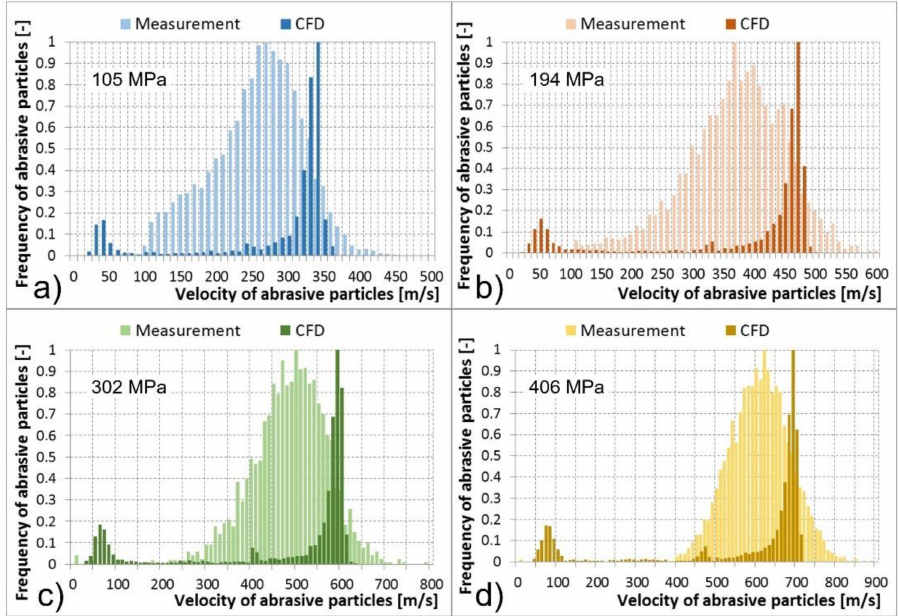
Figure 15. Abrasive particle velocities at the abrasive nozzle outlet, measurement vs. computational models for determined water pressure levels, and an abrasive particle mass flow rate of 300 g/min: ( a ) 105 MPa; ( b ) 194 MPa; ( c ) 302 MPa; ( d ) 406